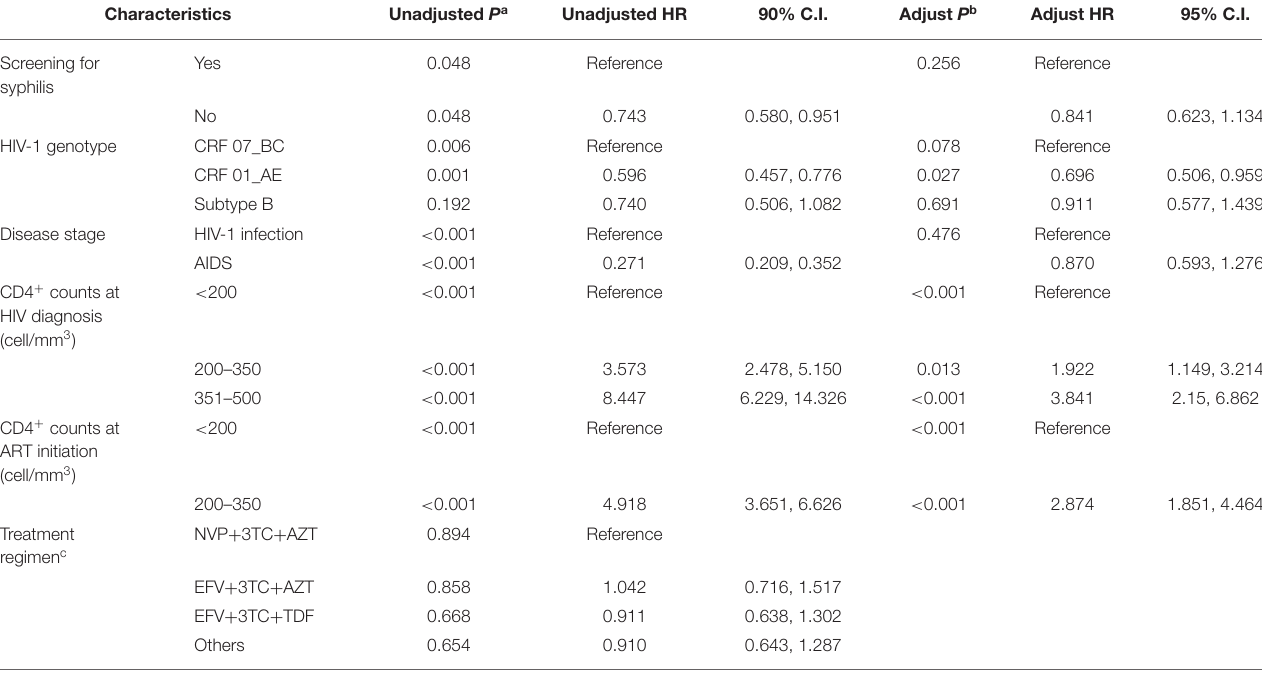
TABLE 6 | Factors associated with the time to CD4 + T-Cell recovery following initiation of ART between HIV-infected MSM with or without syphilis screening during 2008 and 2012 in Guangzhou, China. Characteristics Unadjusted P a Unadjusted HR 90% C.I. 95% C.I.